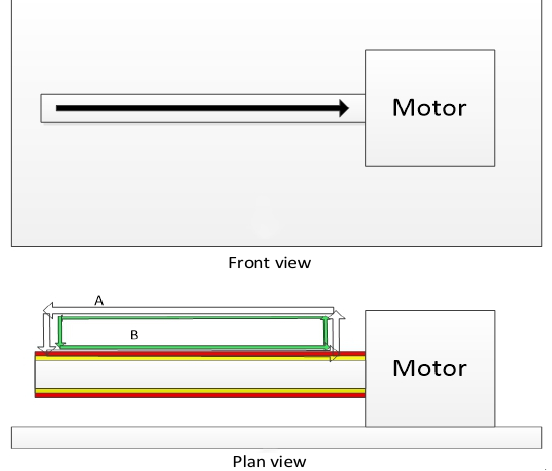
Figure 5. Print path planning of the nozzle. ( A ) Nozzle A movement path and ( B ) nozzle B movement path.